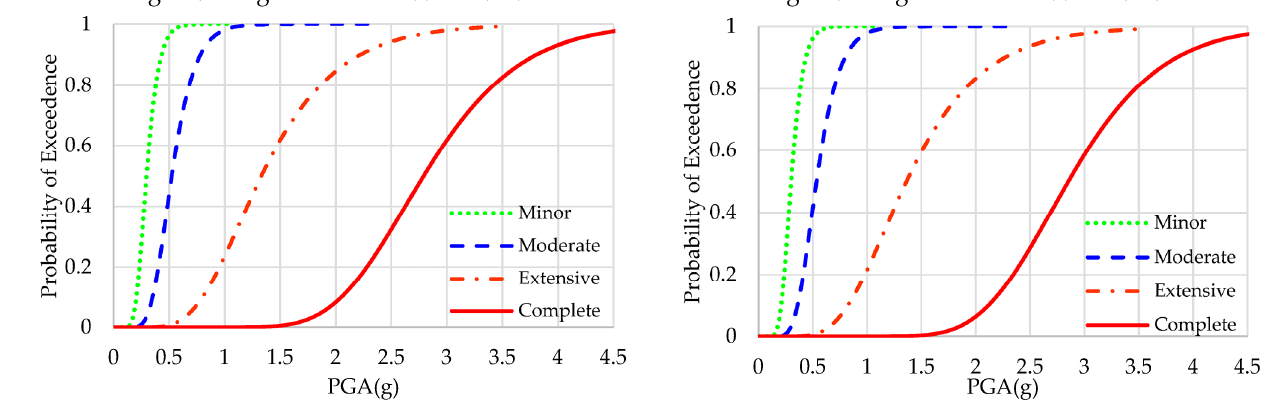
Figure 13. Fragility curves of the original and CFRP flange ‐ bonding frames.